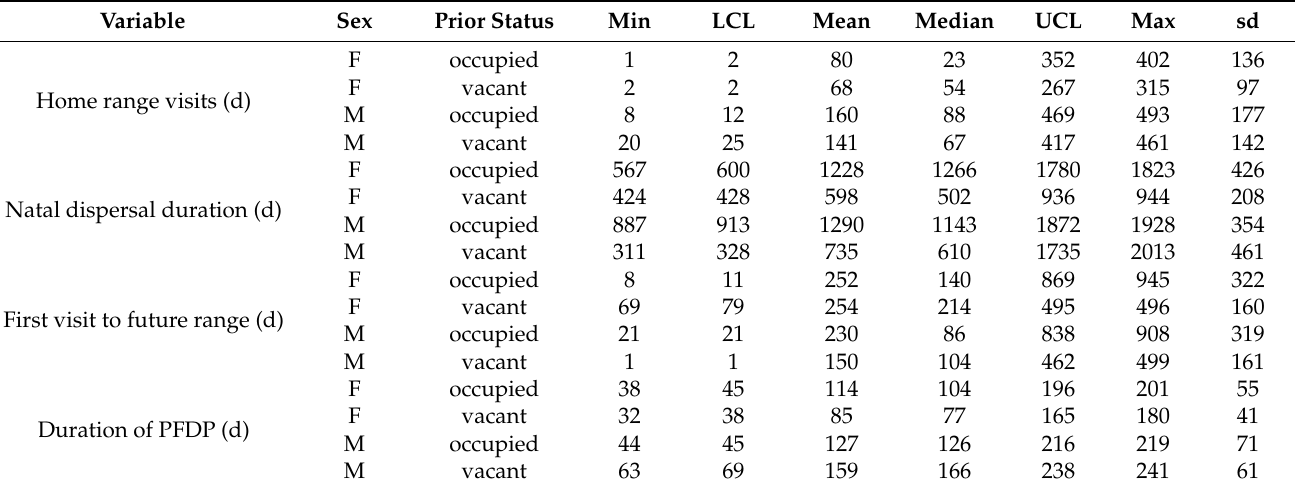
Table 2. Descriptive statistics for the explanatory variable (home range visits: number of unique days), and predictive variables: natal dispersal duration, first visit to the future range and duration of PFDP. These are cast according to sex (M = male F = female) and the status of the future range prior to settlement (occupied or vacant). LCL = 2.5% quantile, UCL = 97.5% quantile.